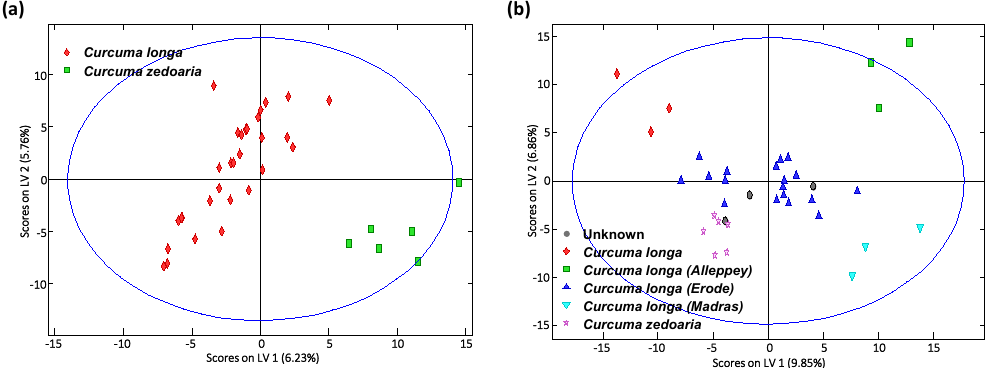
Figure 5. PLS-DA score plots of LV1 vs LV2 when using corrected non-targeted UHPLC-HRMS fingerprints as sample chemical descriptors for ( a ) classification of curcuma longa vs. curcuma zedoaria turmeric samples, and ( b ) classification of turmeric curcuma longa varieties. A total of four LVs were used to build the model.